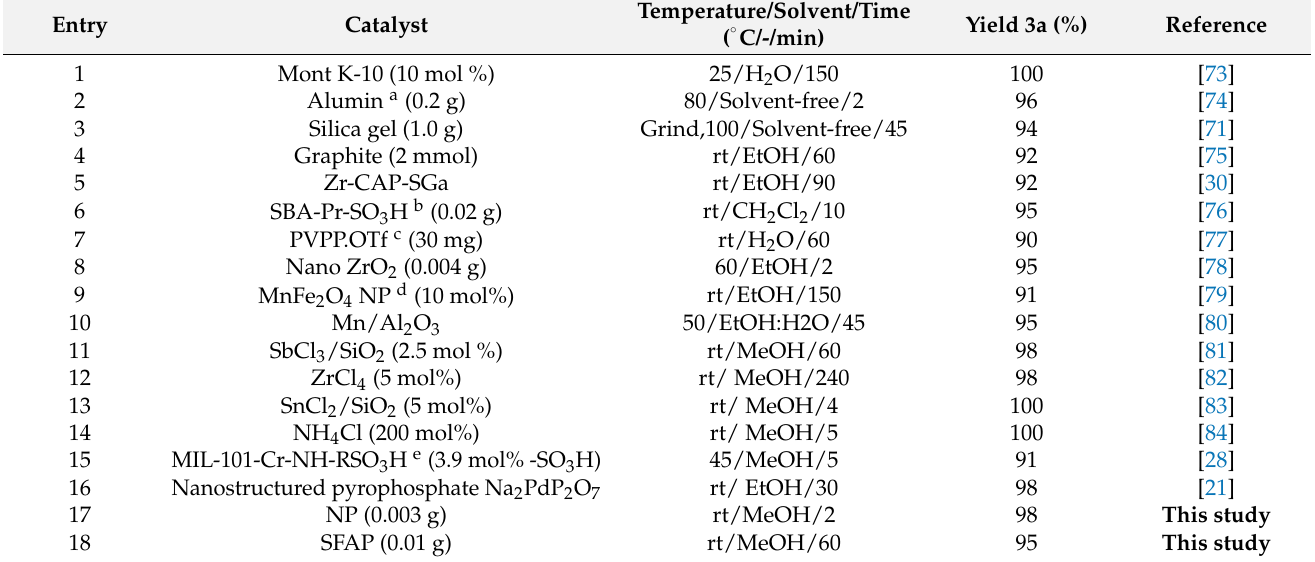
Table 6. Synthesis of quinoxaline using different